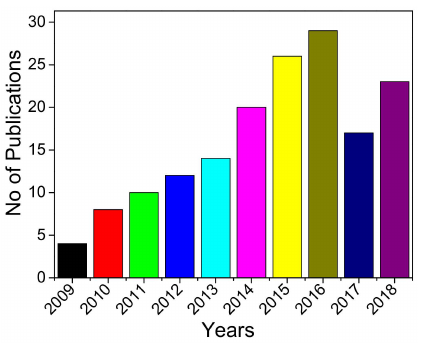
Figure 1. Numbers of publications on melamine sensors from 2009 to 2018 (adopted from Institute for Scientific Information (ISI) Web of Knowledge).